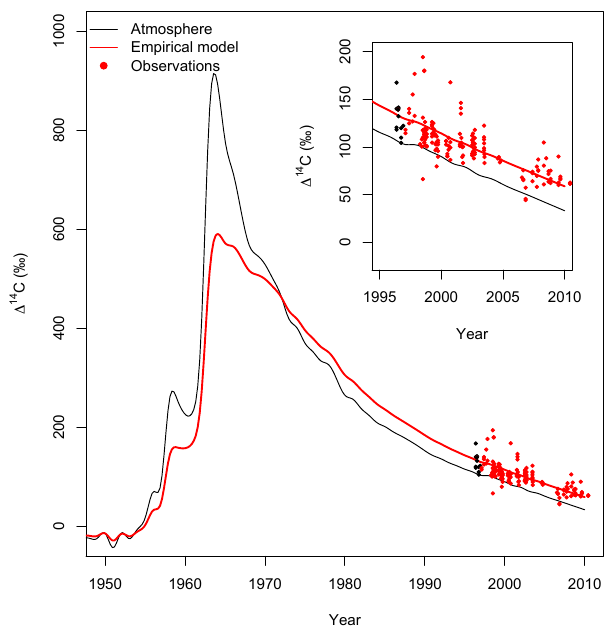
Fig. 2. Comparison of the performance of the empirical model pro- posed by Gaudinski et al. (2000) with measurements of 1 14 C in soil CO 2 efflux conducted in Harvard Forest between 1996 and 2010. Black points represent measurements used to develop the empirical model, and red points independent observations. The atmosphere record is ∼ 5 ‰ below the background atmosphere published by Levin and Kromer (2004), and is based on data collected from tree ring 1 14 C and atmospheric samples (Gaudinski et al.,